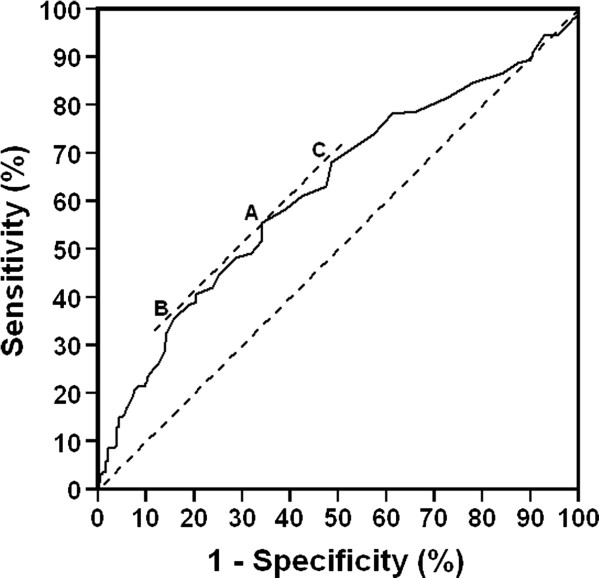
ROC curve for the NLR as a predictor of death due to any cause. The optimum threshold of 2.8 is indicated by A, at which point the positive predictive value was 56% (95% CI 47%-64%). B indicates a threshold of 3.8, at which the positive predictive value was 63% (CI 52%-74%). C indicates a threshold at 2.5%, at which point the positive predictive value was 52% (CI 45%-60%).